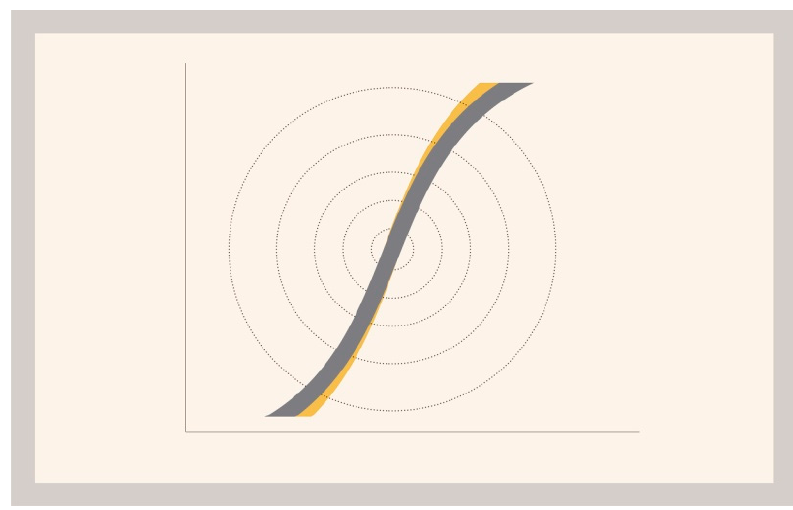
Figure 7. Short term perspective of tensions during global transitional periods. When viewed only from a short-term perspective, the tension and conflict inherent in the transition may seem chaotic and symptomatic of a disintegrating, collapsing world.